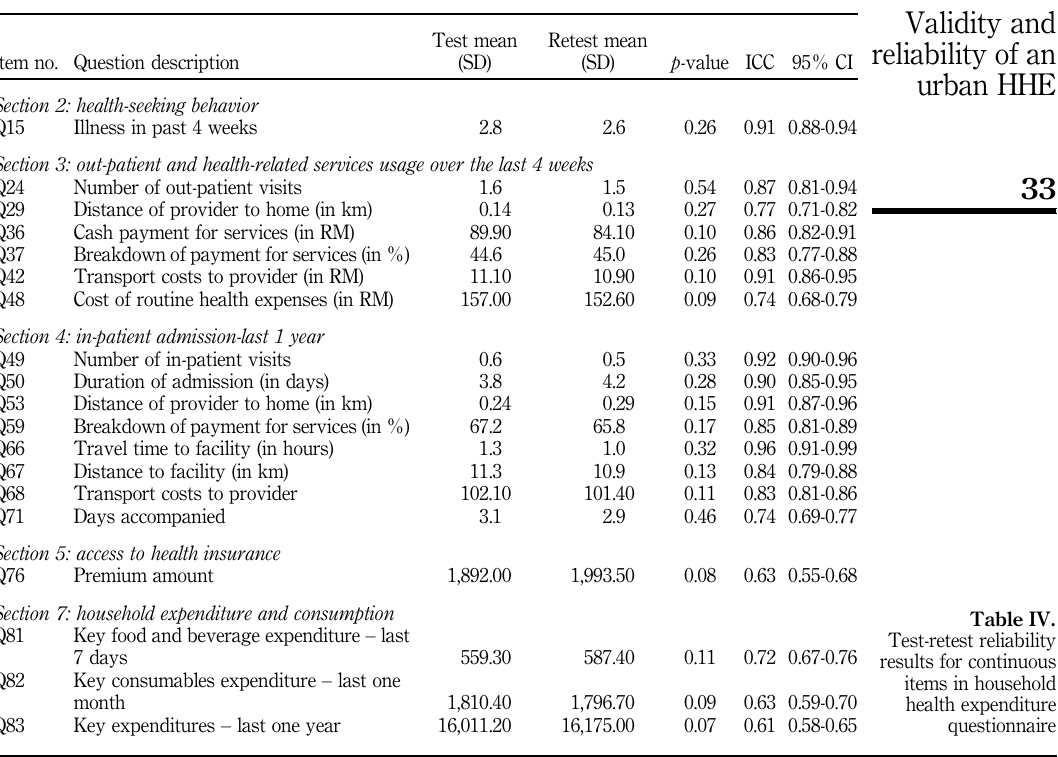
Table IV. Test-retest reliability results for continuous items in